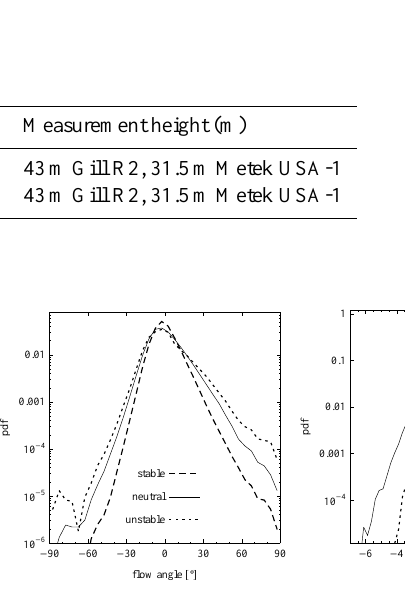
Table1. Overviewofexperimentsusedforinstrumentintercomparison.